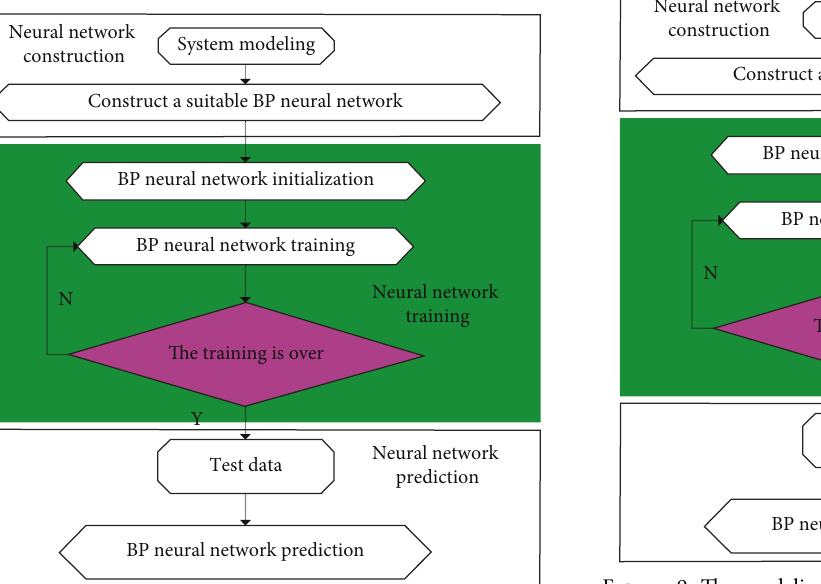
Figure 8: Flow chart of the BP algorithm.